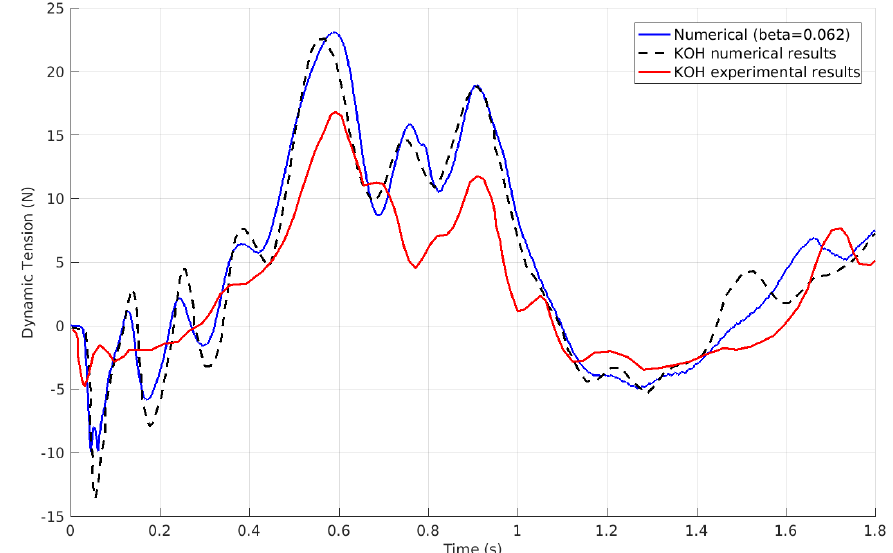
Figure 11. Optimal validation with Koh’s experiment results.